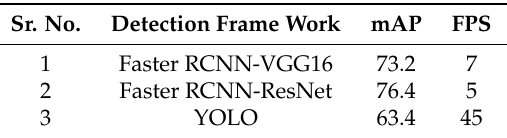
Table 2. A brief comparison based on mean average precision (mAP) and frame per second (FPS) is made here and this study is taken from the following source